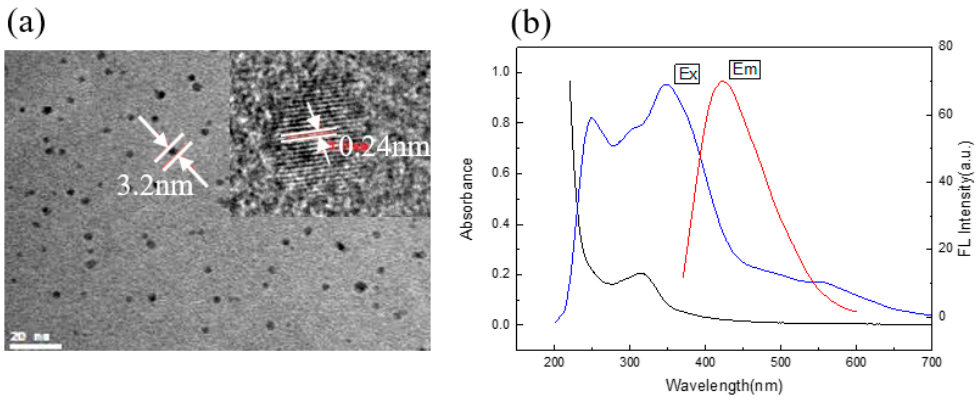
Figure 1. ( a ) The TEM images of C / N-dots; ( b ) UV-vis absorption (black line) and excitation (blue line) and emission (red line) spectra of the aqueous dispersion of the C/N-dots.